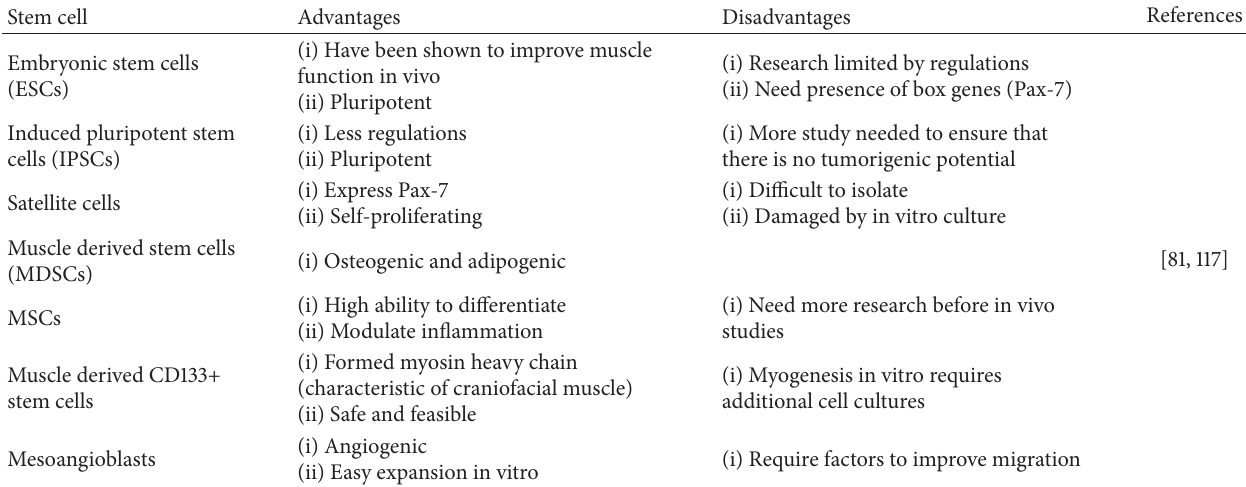
Table 3: This table shows potential SCs for use in muscle regeneration and their positive and negative characteristics. Stem cell